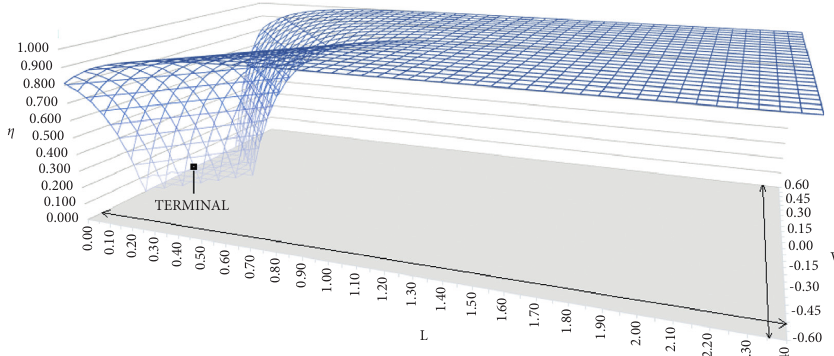
Figure 1: Values of the attractiveness coefficient across a service area with L � 2.4km and W � 1.2 km. In this example, we set c � d 0 � 0.3km. From a temporal point of view, the demand follows a Poisson process with λ as the rate parameter.